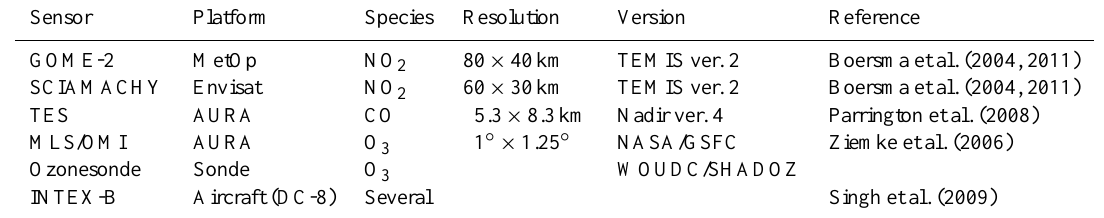
Table 2. List of observations used for the validation. Sensor Platform